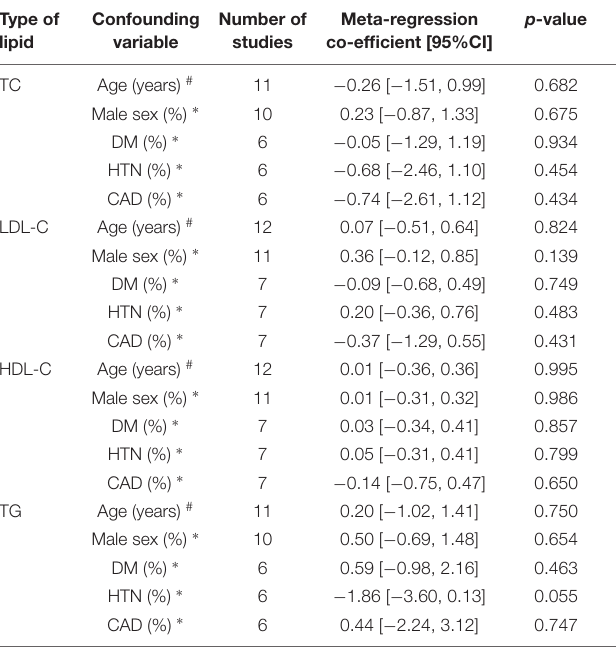
TABLE 2 | Meta-regression analysis to assess the impact of the confounding variables on the mean difference of lipid levels (mg/dL) between patients with and without severe COVID-19